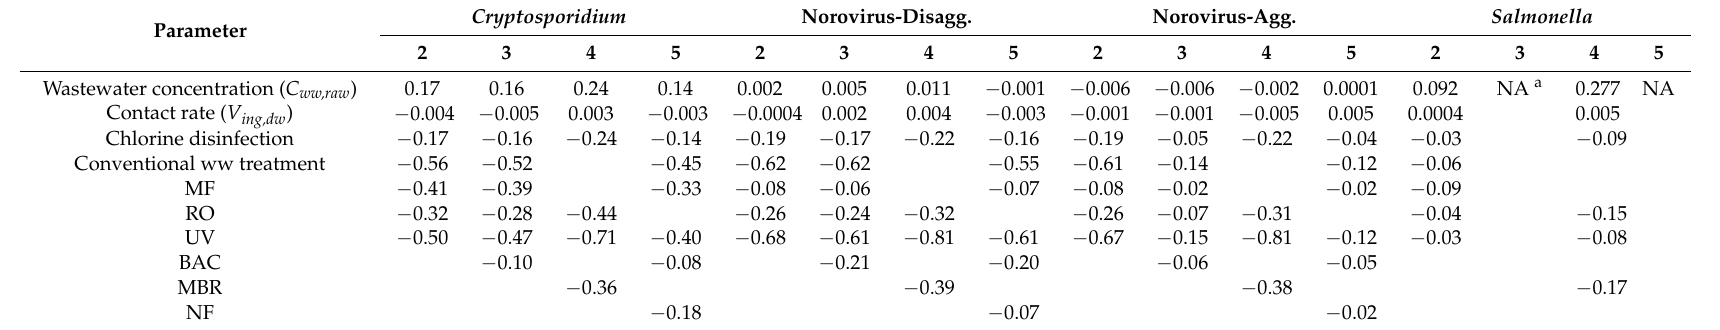
Table 5. Sensitivity analysis with Spearman rank correlation coefficients for DPR treatment